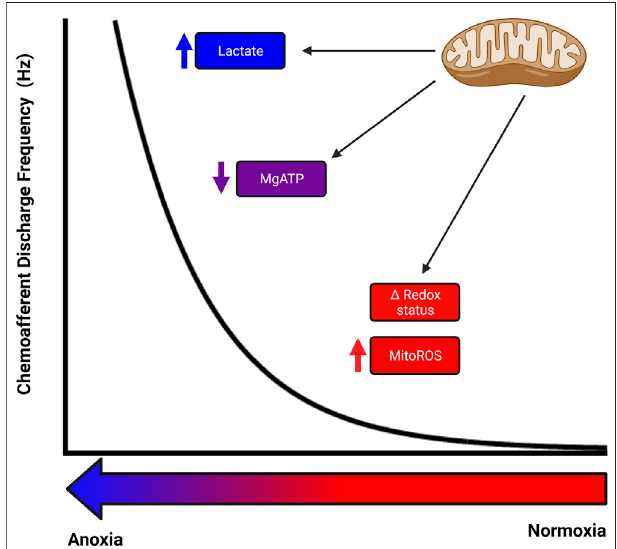
FIGURE 3 | Potential for numerous mitochondrial related signalling mechanisms to co-operate to produce the full carotid body response to hypoxia. Different mitochondrial related signalling mechanisms could be responsible for the rise in chemoafferent discharge at different levels of hypoxia, with an alteration in cellular redox status and mitochondrial reactive oxygen species acting during mild-moderate hypoxia, a decrease in MgATP being important during moderate-severe hypoxia and an increase in lactate contributing during severe hypoxia. There may well be signi fi cant